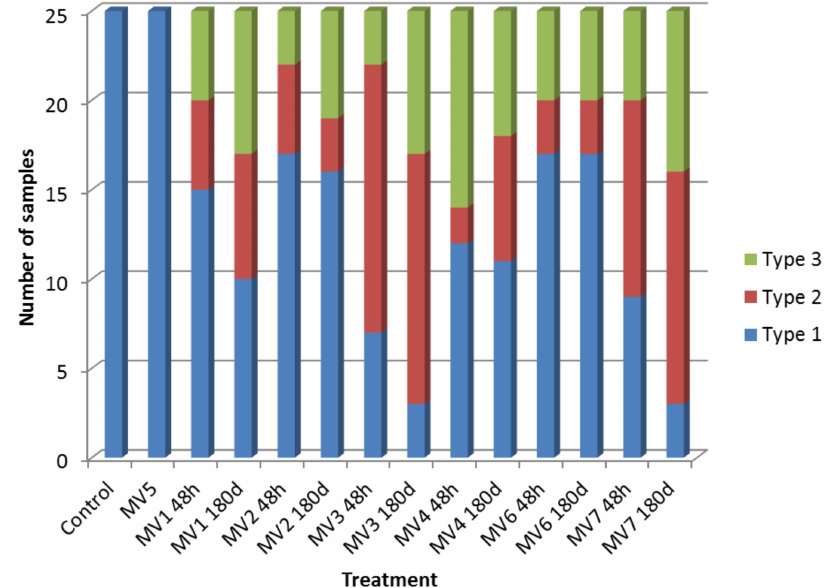
Figure 1. Incidence of mode of failure for each experimental group at different storage